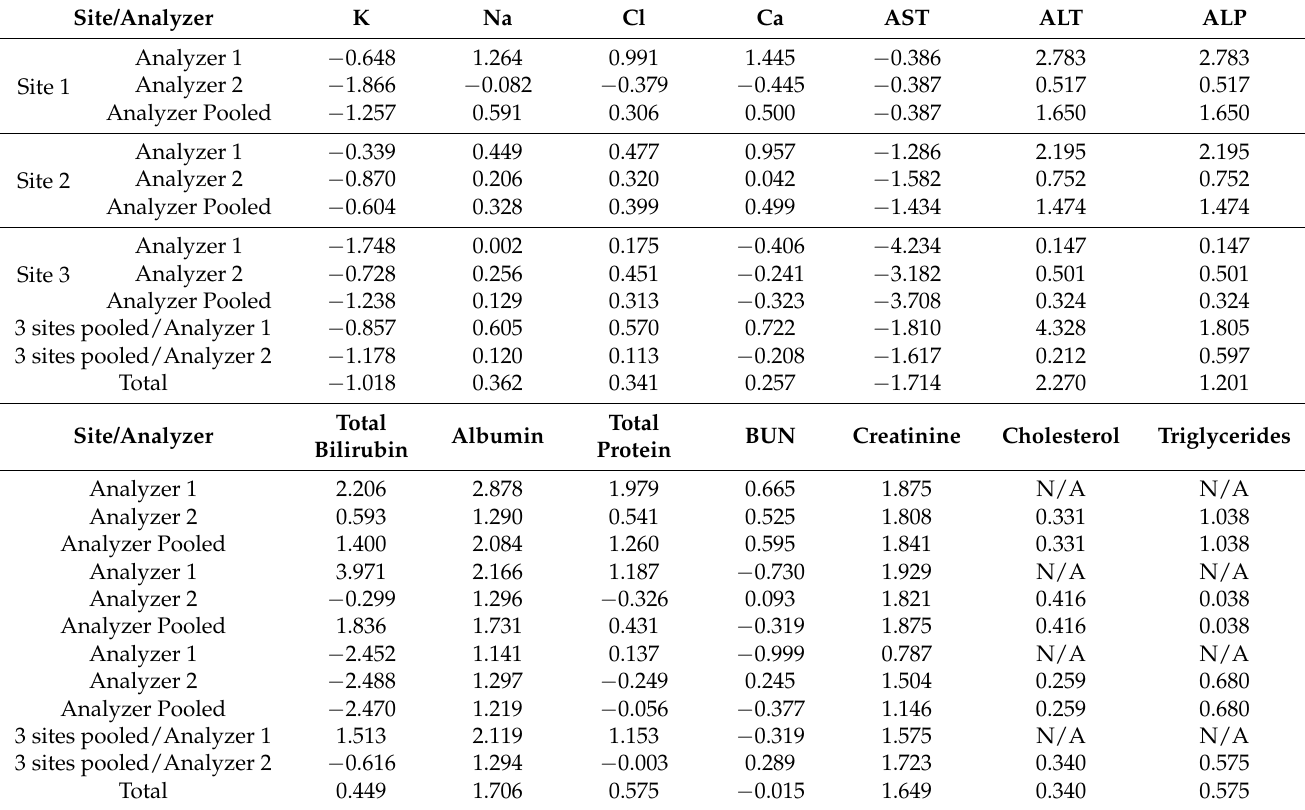
Table 2. Mean percent bias for all analytes at each site and for each chemistry analyzer.